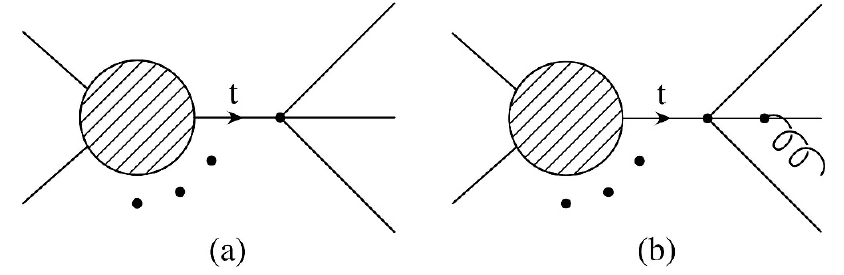
Figure 1 . Parton-level top decays, with and without a (cid:12)nal-state gluon